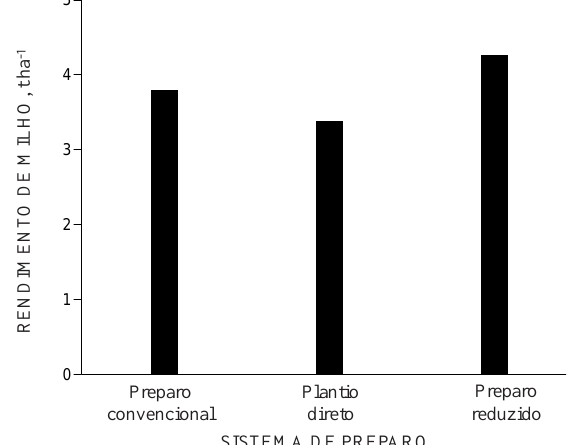
Figura 3. Rendimento de grãos de milho, considerando três sistemas de preparo, média de três sistemas de rotação de cultura e duas formas de cobertura do solo. Médias não diferiram pelo teste Duncan a 5 %.